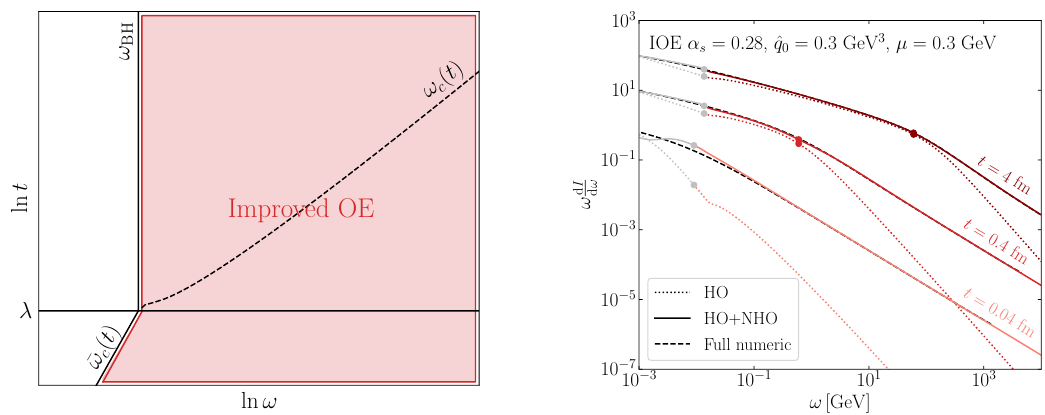
Figure 6 . Left: the sketch of region of validity (and convergence) of the improved opacity expansion for different propagation length t and emission energy ω . Right: the induced emission spectrum for gluons in the improved opacity expansion. The gray part of the curves denotes regions where the expansion is not valid. Using the parameters presented, λ = 0 . 06 fm. The full numeric solution is also presented with dashed